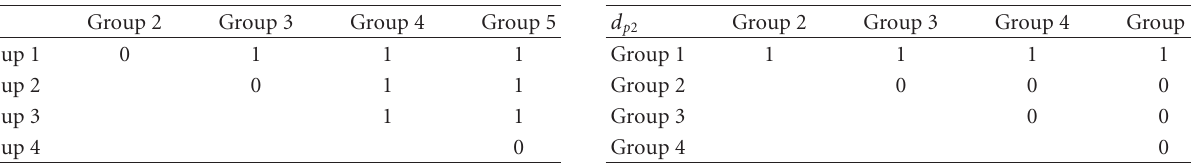
Table 3: Pairs of groups for d p 1 for which the filter lifespans di ff er significantly from each other.